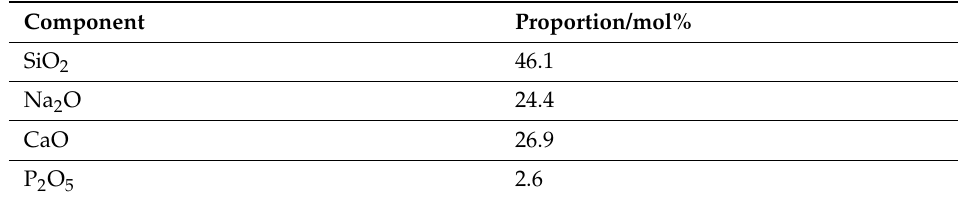
Table 3. Composition of Bioglass ® [38].